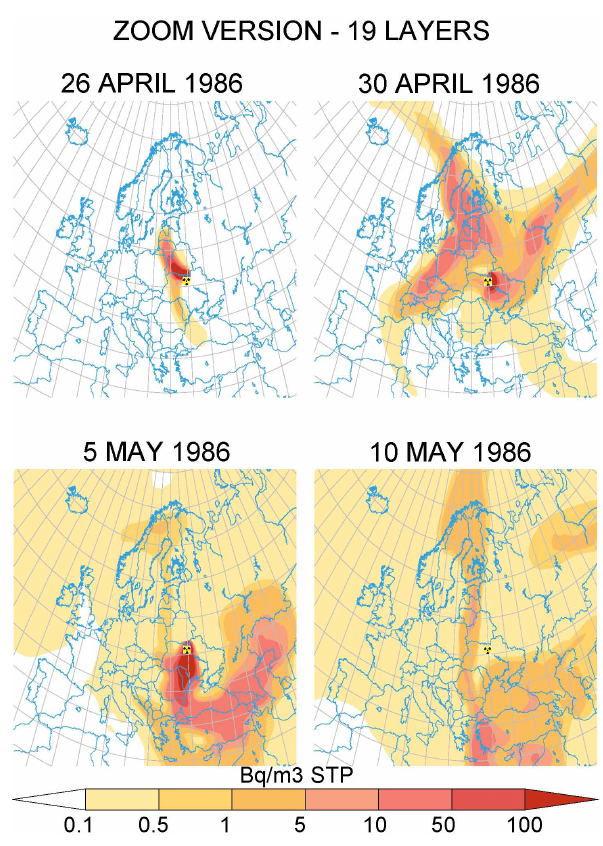
Fig. 5. Daily mean surface 137 Cs activity concentrations (in Bqm − 3 STP) from the Chernobyl accident. Model with regular grid stretched over Europe and 19 vertical levels and injection at the real emission height (Table 1) (Z19L). The figures show the situation during the first day (26 April 1986), at the end of April (30 April 1986), the last day of the emissions (5 May 1986) and on 10 May 1986.